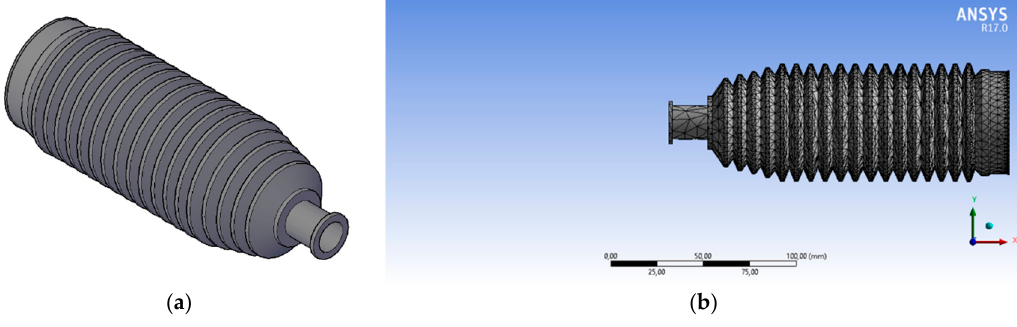
Figure 8. 3D model of a cuff: ( a ) isometric view; ( b ) the mesh of finite elements.